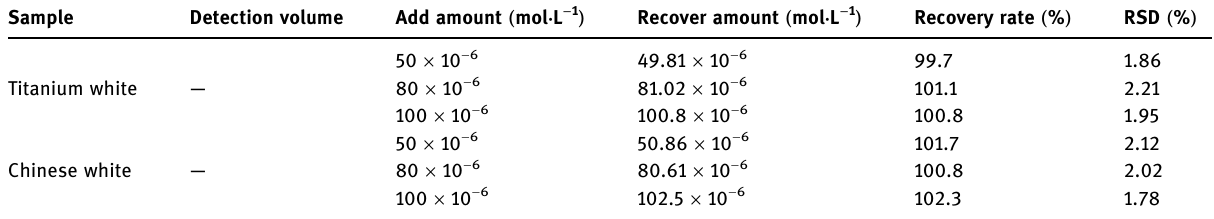
Table 2: Sample determination experiment ( n = 6 ) Sample